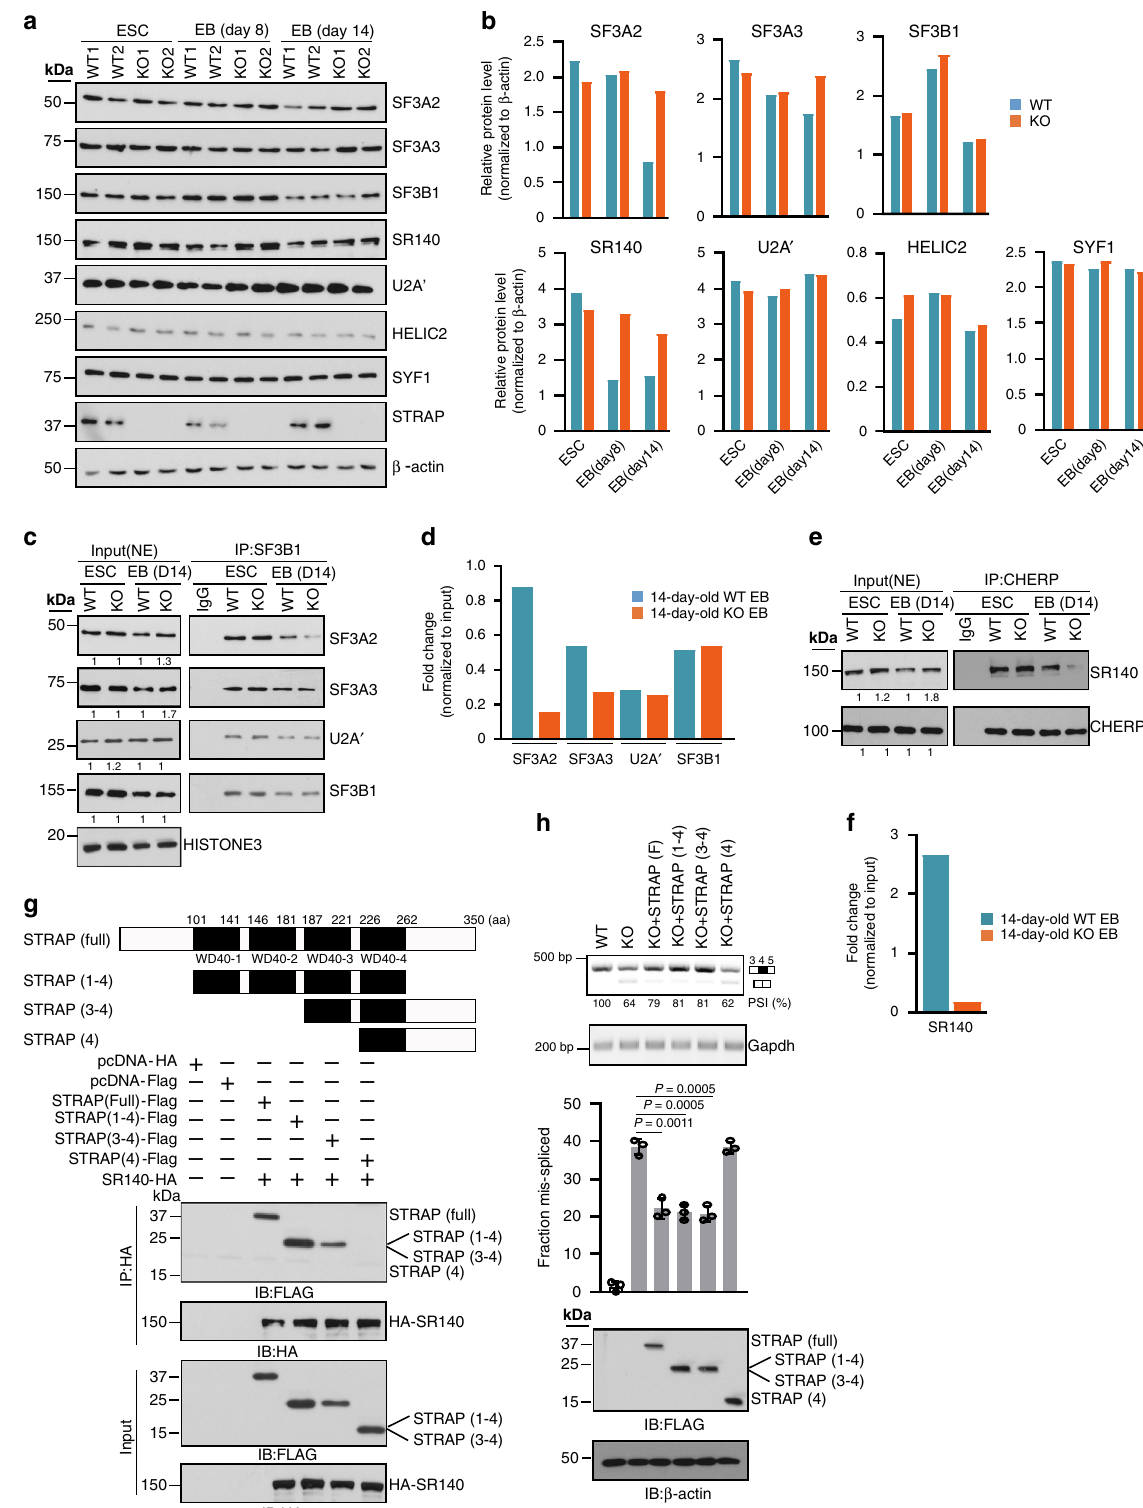
based on SEQUEST search results were fi ltered using Scaffold (version 3.0). The fi lter cut-off values were set with a minimum peptide length of >5 AA ’ s, with no MH + 1 charge states, with peptide probabilities of >80% C.I., and with the number of peptides per protein ≥ 2. The protein probabilities were then set to a>99.0% C.I., and an FDR < 1.0%. STRAP binding-partners were ranked by a COMPLEAT online tool (http://www. fl yrnai.org>compleat) 29 . The enrichment P- value was calculated based on the permutation: generate 1000 random lists of input data